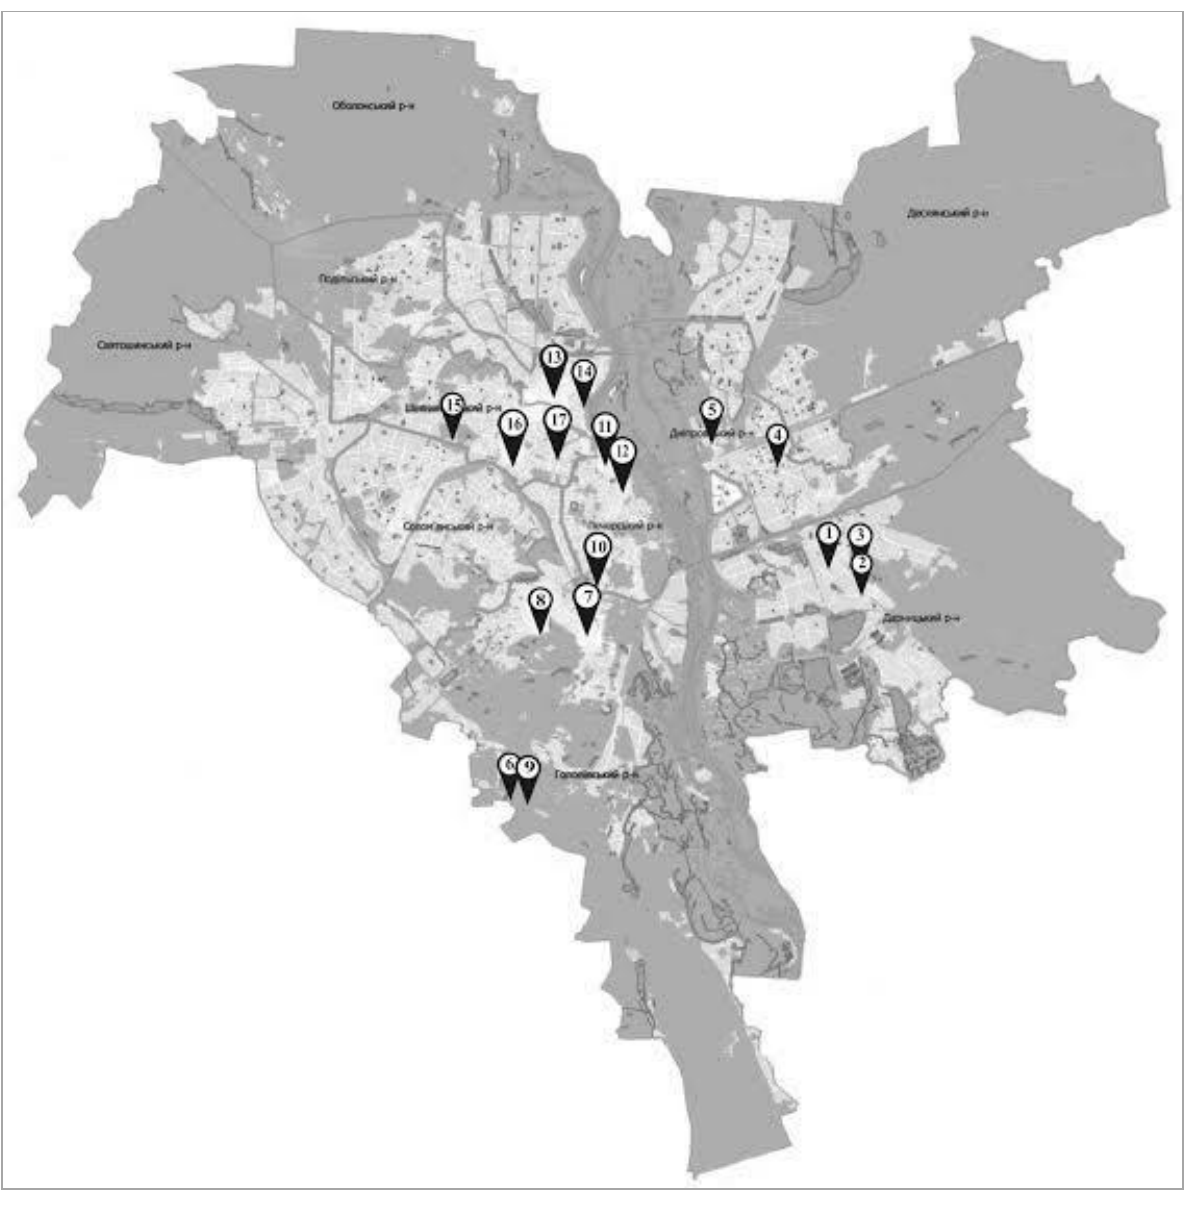
Fig. 1. Sampling sites in Кyiv